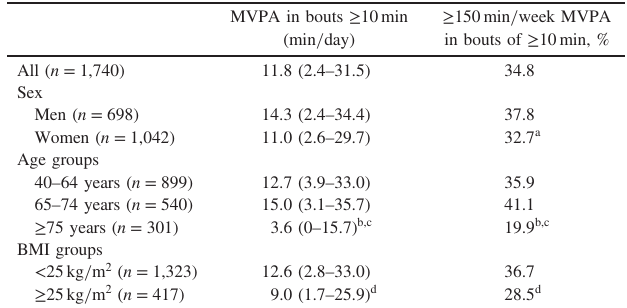
BMI, body mass index; MVPA, moderate-to-vigorous physical activity. Values are median (interquartile range). a Signi fi cant sex di ff erence ( P < 0.05) vs men. b Signi fi cant age group di ff erence ( P < 0.05) vs 40 – 64